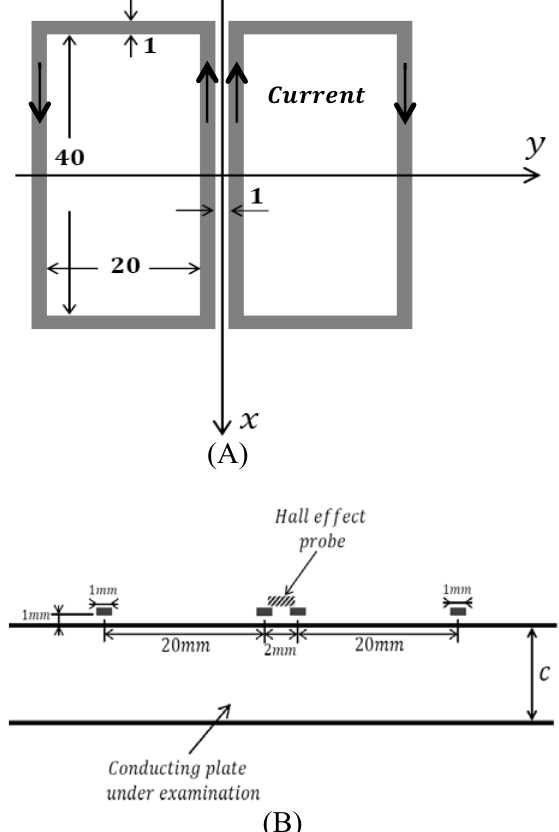
Figure 1: (A) Top view of the rectangular double printed coil; (B) Side view of this coil above an aluminum